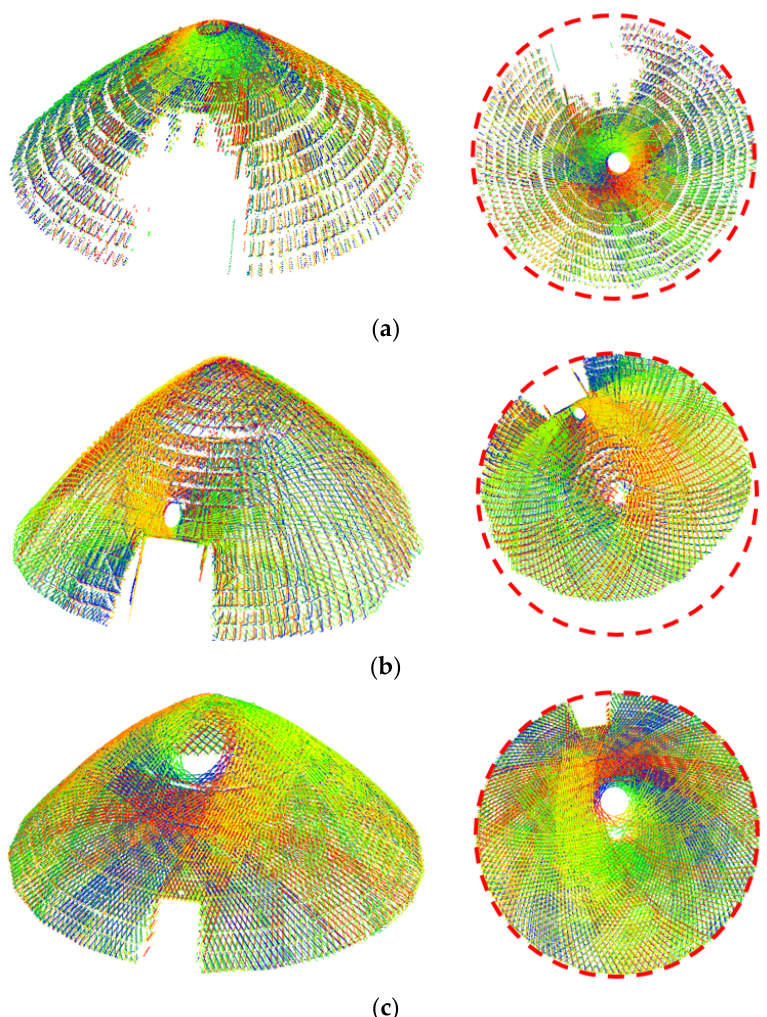
Figure 27. Perspective view (left) and top view (right) of the extracted roof feature for: ( a ) Lebanon , ( b ) Frankfort , and ( c ) West Lafayette datasets (points are colored by scan ID with the red circle showing the outline of the facility).